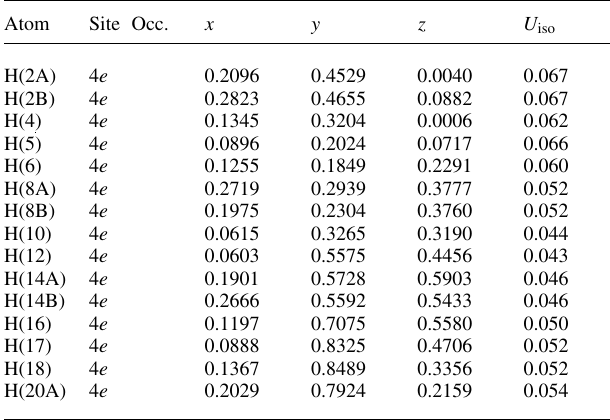
Table 2. Atomic coordinates and displacement parameters (in Å 2 )